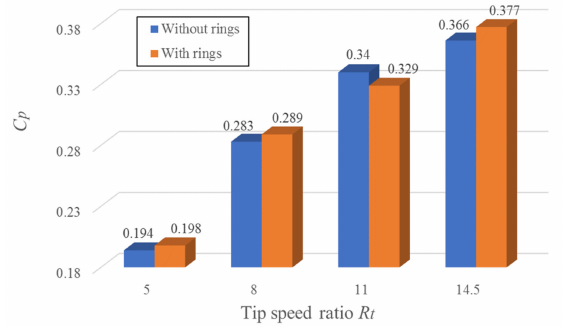
Figure 14. The C P obtained at different tip speed